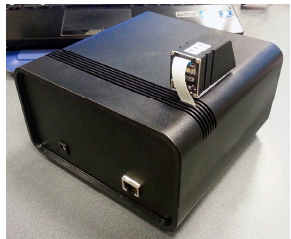
Figure 9. Rear view of the first prototype.